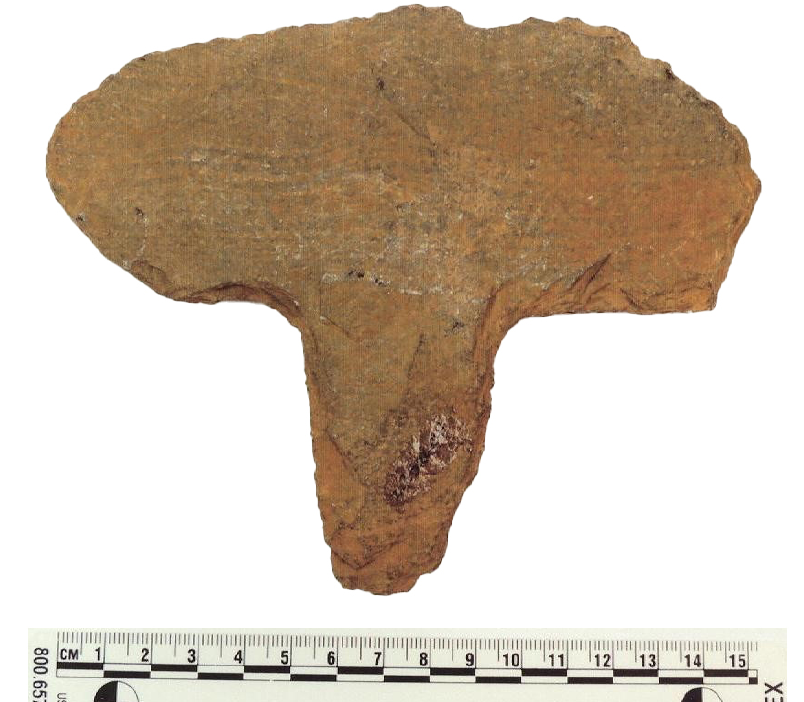
Figure 4. Photograph of Wide (or T-shaped) variety (by Healy, courtesy of the Cambridge University Museum of Archaeology and Anthropology; Cat. No. Z35260F; scale in cm).